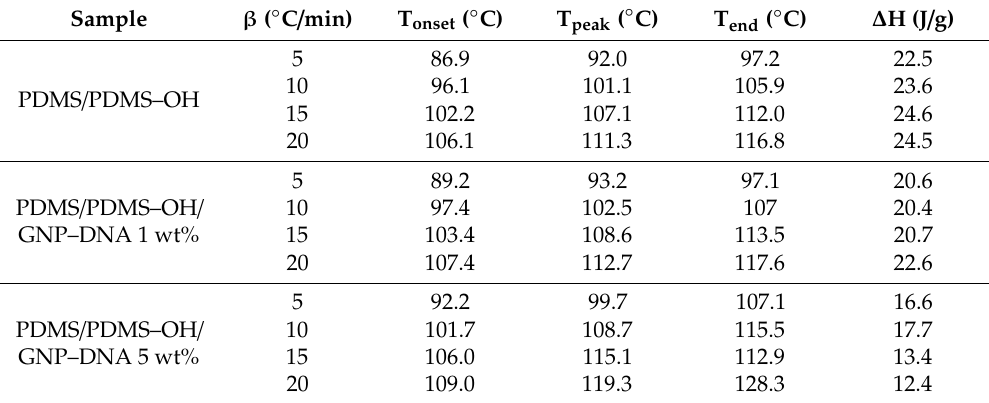
Table 2. Curing process parameters for the PDMS / PDMS–OH (75:25 w / w) blend and its nanocomposites with GNP–DNA filler from DSC dynamic scans at di ff erent heating rates.